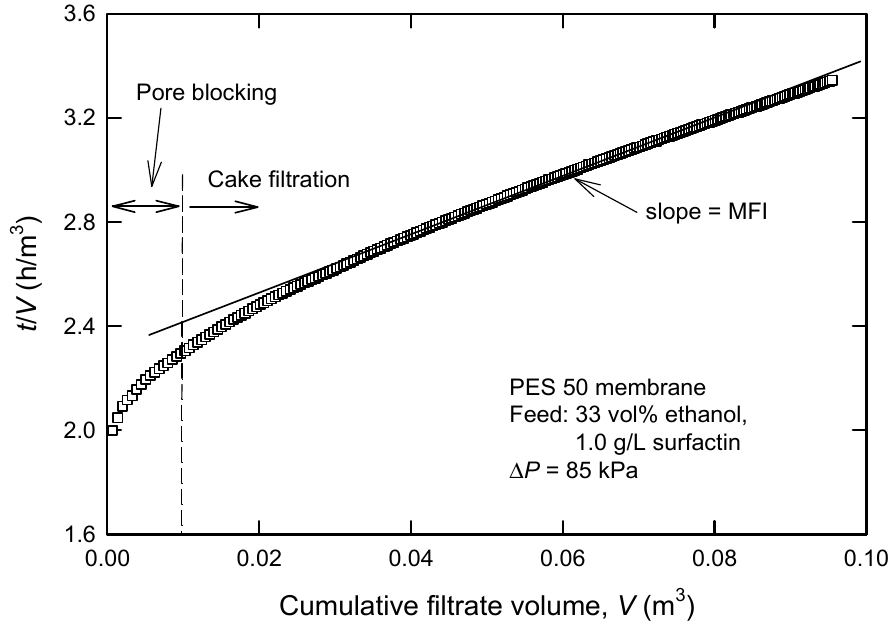
Figure 2. Typical plot for the determination of modified fouling index (MFI) in UF processes. The typical curve is then followed by a minimum linear slope in the second region, where particles deposit on the surface of the membrane. The so-called modified fouling index (MFI) is essentially based on cake filtration (region 2); in this case, particles are retained on the membrane surface as a cake. The cake will add an additional resistance ( R c ) to the resistance of the membrane itself ( R m ); therefore, flux decline under constant pressure filtration can be described by [15,18]: